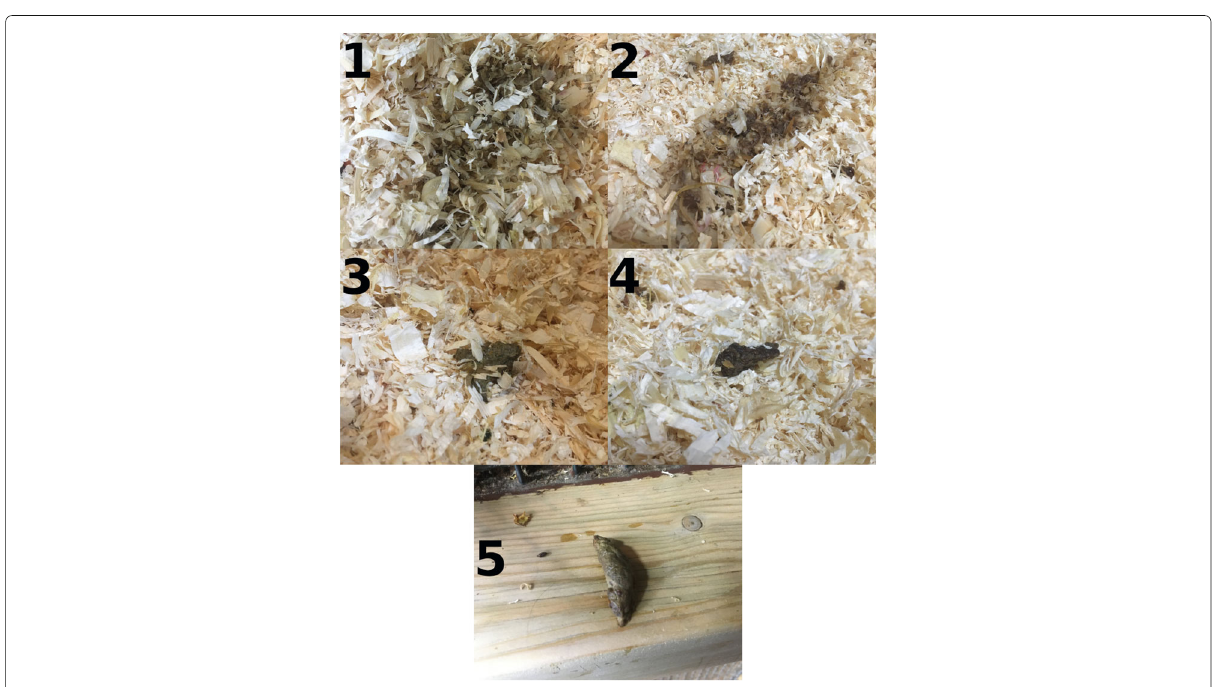
Fig. 7 Faecal scoring guide in pied tamarins. Grade 1: very liquid faeces, no evidence of large particles, spread over large area; Grade 2: Very soft faeces, spread over small area, some solid particles present; Grade 3: Faeces have pasty consistency, no significant spread, not forming a pellet; Grade 4: Faeces forming a pellet but fragmented and showing soft consistency.; Grade 5: Faeces forming a pellet that maintains shape and integrity when manipulated